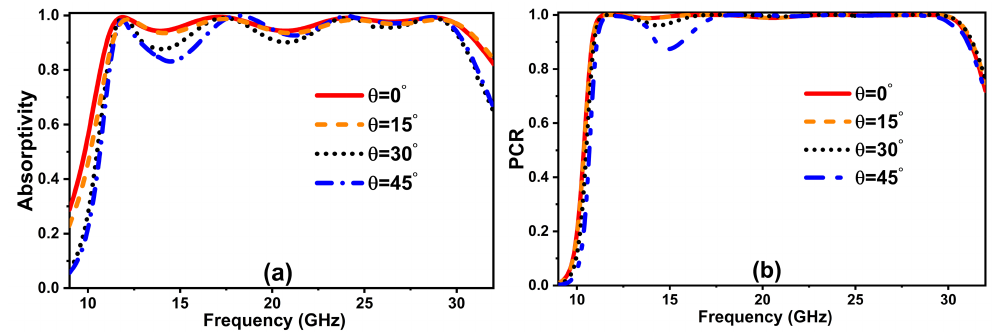
Figure 10. ( a ) Absorptivity and ( b ) PCR responses at different oblique